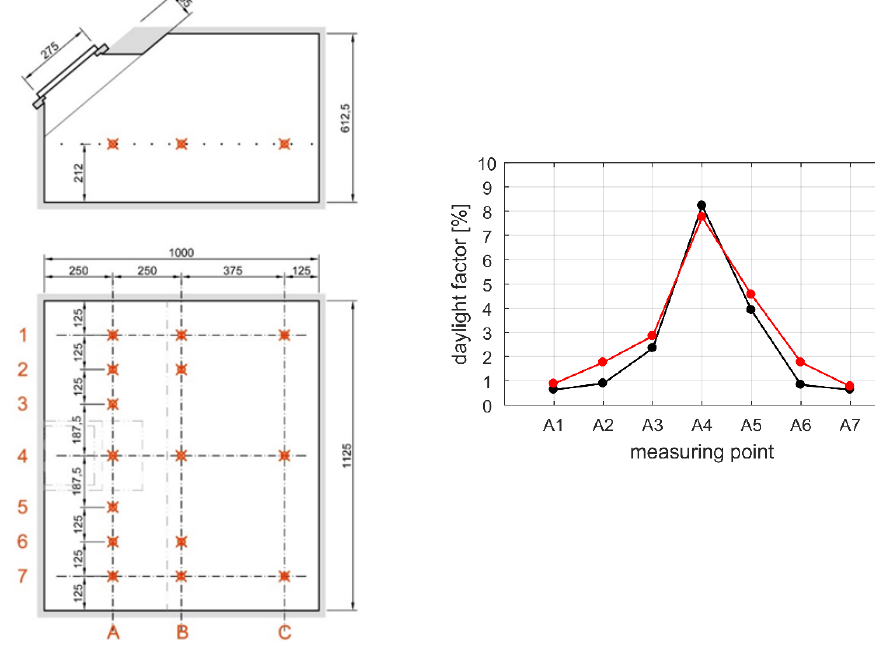
Figure 16. Laboratory-measured values of the daylight factor. Measured points ( left ) and values for points A1 to A7 ( right ). The black line represents the perpendicular side-lining and the red line represents the slanted side-lining with a slant angle of 45 ◦ . (Unit: